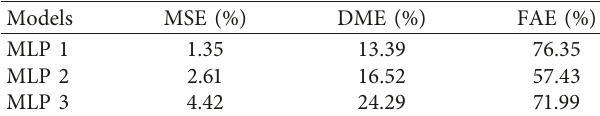
Table 8: Training result summary for structural beam with a